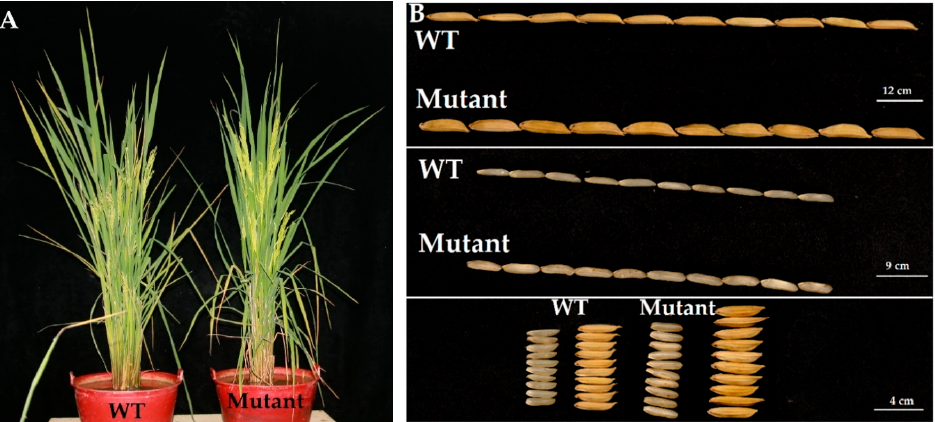
Figure 3. The plant (A) and grain phenotype (B) of wild type (WT) and mutant lines. Seeds were randomly collected from GXU52-3, GXU52-6, and GXU52-8 mutant lines for phenotyping.